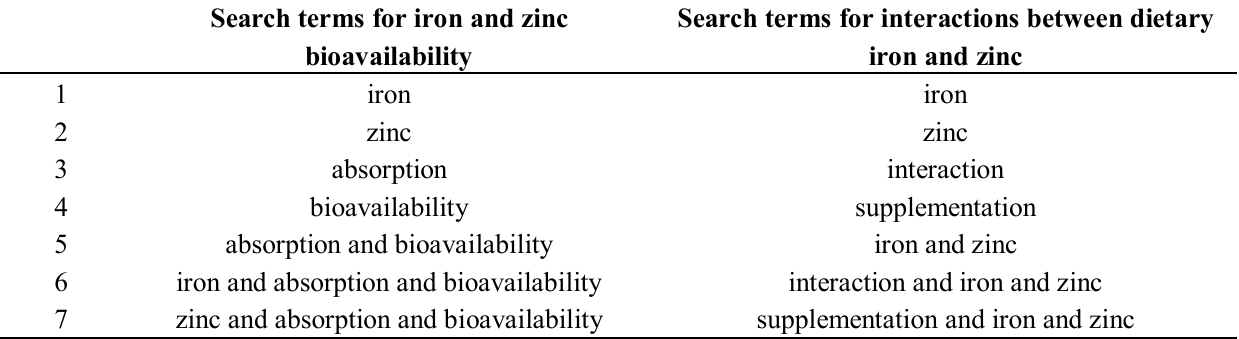
Table 1. Summary of literature search